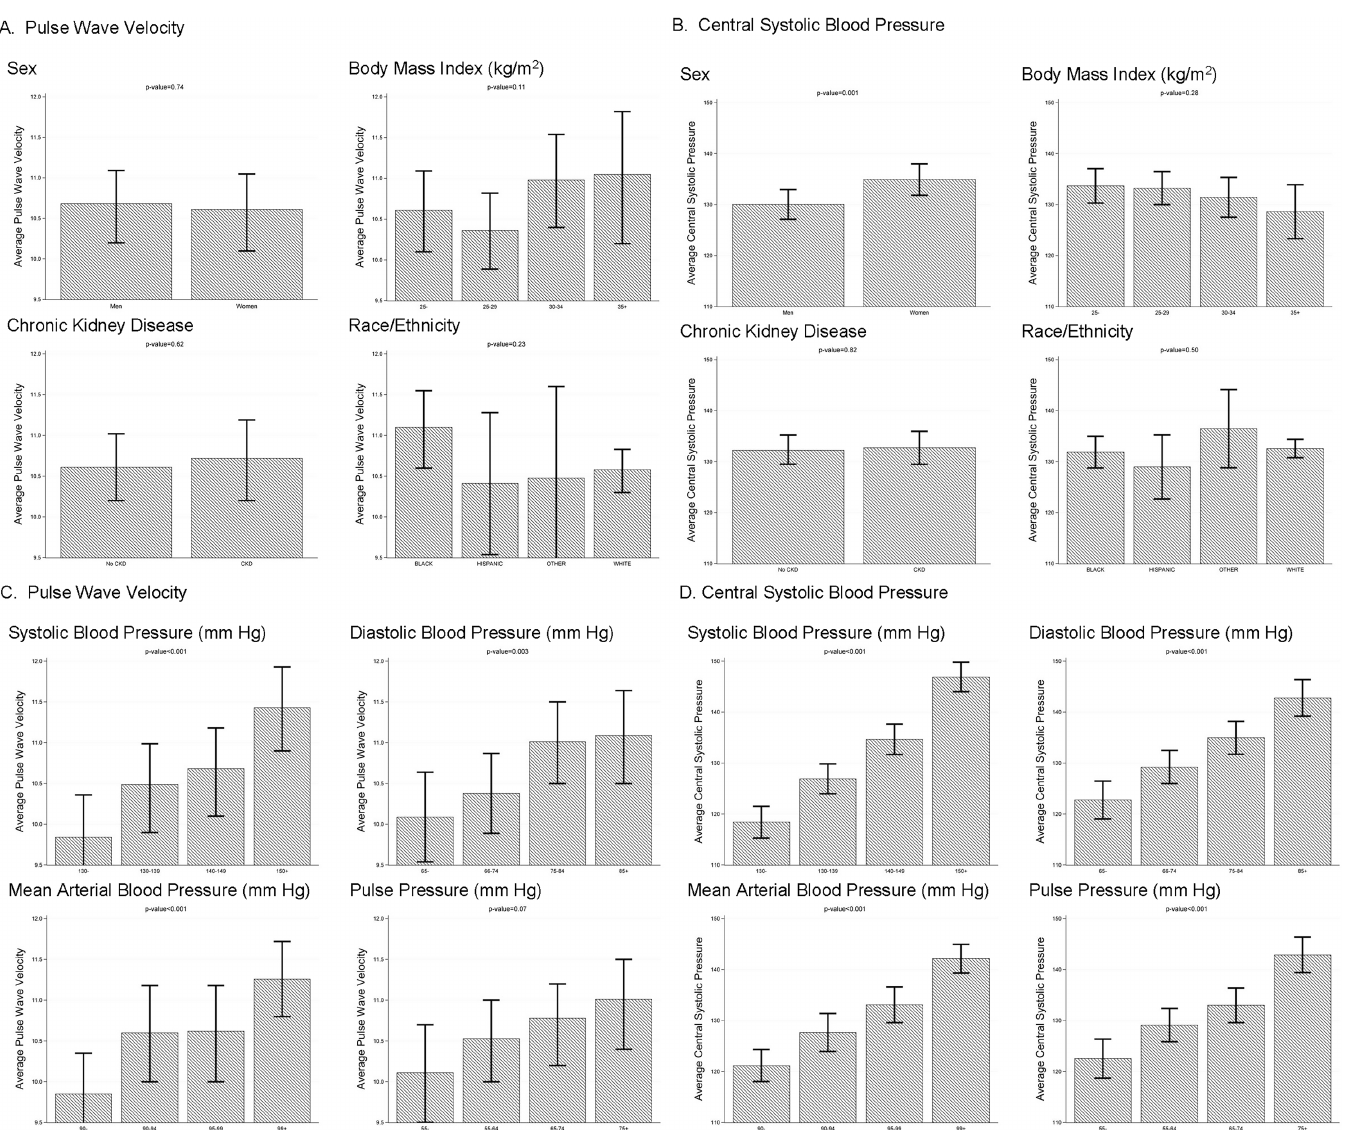
Fig 1. Least square means and 95% confidence intervals for pulse wave velocity and central aortic blood pressure: generalized linear models with adjustments for sex, race, and age. https://doi.org/10.1371/journal.pone.0203305.g001 PLOS ONE | https://doi.org/10.1371/journal.pone.0203305 September 26,